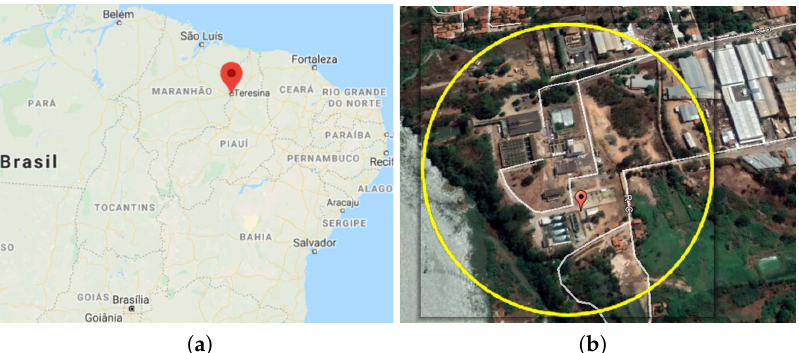
Figure 2. ( a ) Map of Brazil where scenario is localized; ( b ) area covered by the water